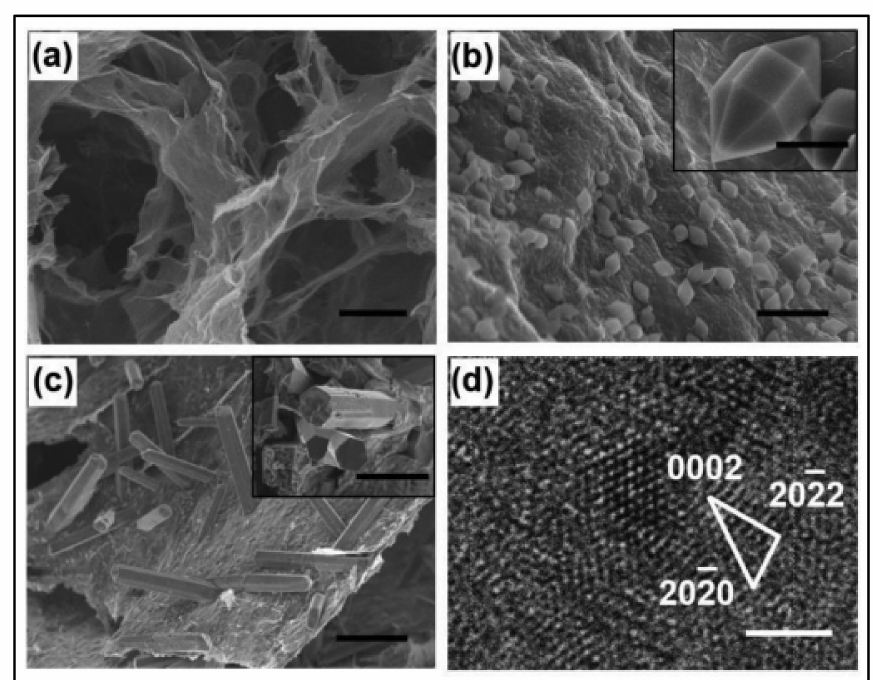
Figure 9. ( a – c ) SEM images of the GA, GAMOF, GAMOF composite, ( d ) TEM of the GAMOF. Reprinted with permission from Liu, Lin, et al. Growth-oriented Fe-based MOFs synergized with graphene aerogels for high-performance supercapacitors. Adv. Mater. Interfaces 2018, 5, 8, 1701548. Copyright © 2018 WILEY-VCH Verlag GmbH & Co. KGaA, Weinheim